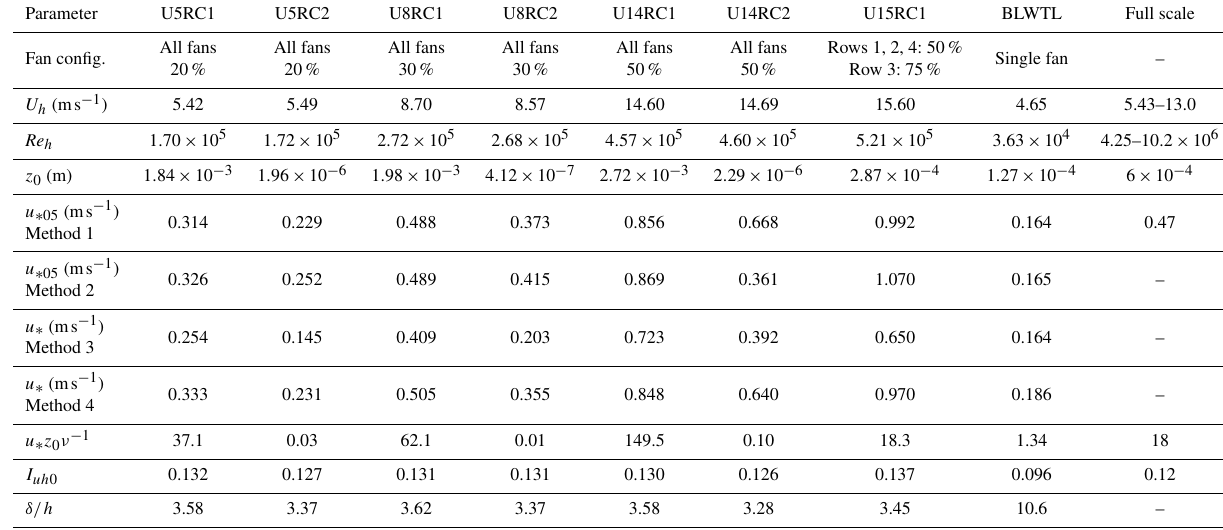
Table 1. Inflow parameters for WindEEE and BLWTL test cases. Parameter Full scale Fan config.